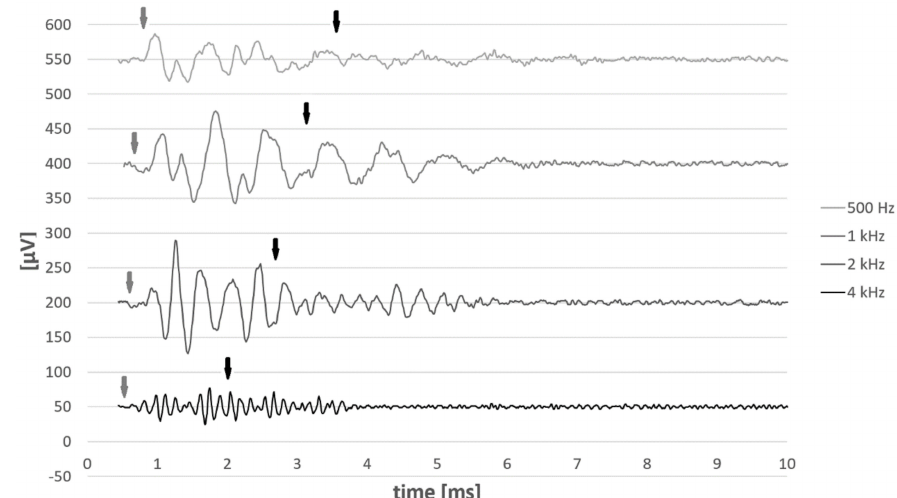
Figure 6. Example of signal-front and BM group delays derived from click response. The recordings were performed from the electrodes closest to characteristic frequency of 0.25, 0.5, 1, 2, and 4 kHz. The responses to condensation and rarefaction polarity click were subtracted, then filtered. The filters used were HP filters with the cut-off frequencies equal to each characteristic frequency (i.e., trace 1 was HP-filtered with 500 Hz cut-off frequency). Grey arrows depict the BM signal front delays, and black arrows depicts the BM group delays.